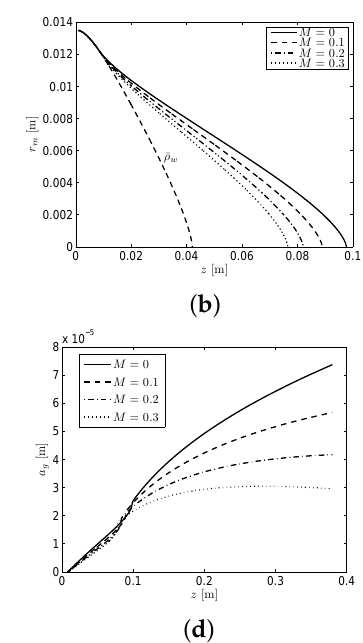
Figure 8. Dependence on M of: ( a ) the taper profile, r w ( z ) , relative to W ; ( b ) the position of the solid/air interface, r m ( z ) ; ( c ) the position of the solid/air interface, r a ( z ) ; and ( d ) the width of the air gap, a g ( z )